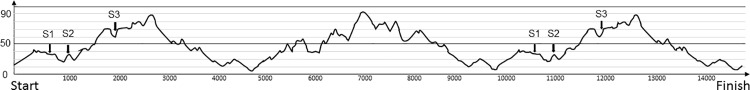
Profile of the 15-km classical cross-country skiing race course.The skiers covered three 5-km laps, two on track A (the first and final laps) and one on track B (the second lap). S1 (flat terrain, 0° incline), S2 (intermediate, 3.5°) and S3 (uphill, 7.1°) indicate the sections on which the skiers were filmed. See the text for further details.